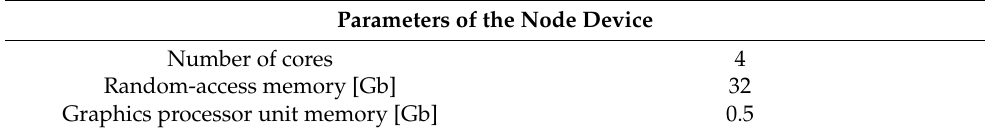
Table 6. The parameters of the node